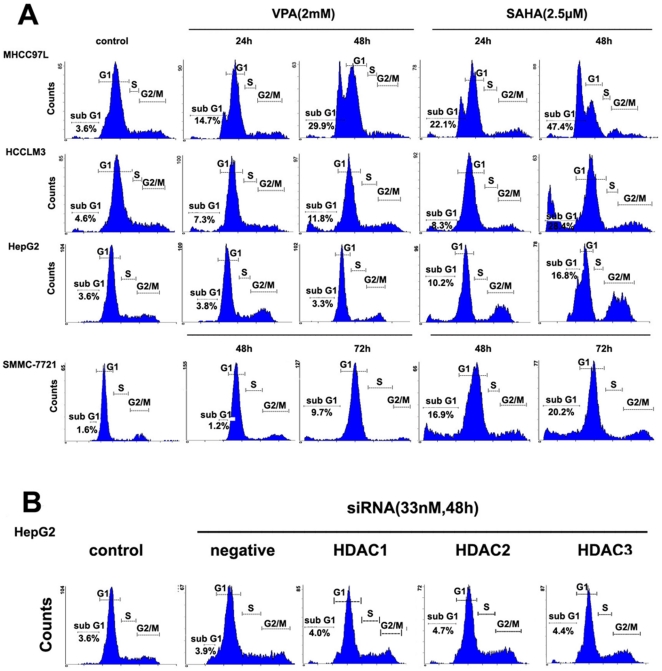
Apoptosis-inducing and cellcycle alteration effects of HDIs and selective HDAC siRNA silencing in HCC.(A) Flow cytometric analysis of apoptosis and cell cycle in 4 HCC cell lines after the treatment with the DMSO vehicle or the indicated concentrations of VPA and SAHA for 24, 48, or 72 hours. (B) Apoptosis and cellcycle alterations in HepG2 after selective silencing of HDAC1, 2, 3 for 48 hours.